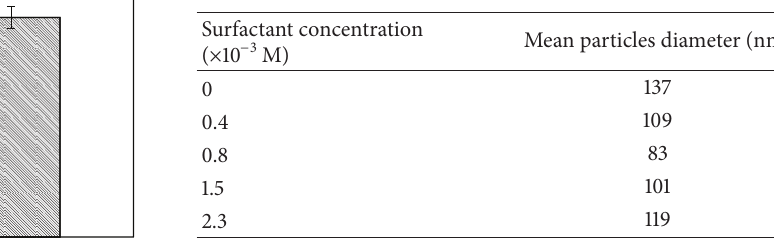
Table 2: Effects of surfactant concentration on mean particles diameter of curcumin loaded starch